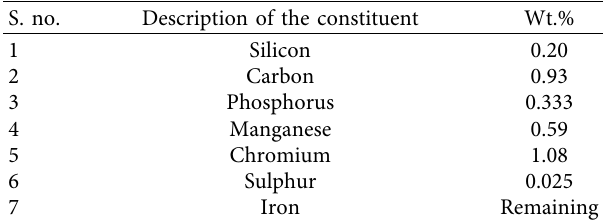
Table 1: Chemical test results of EN31